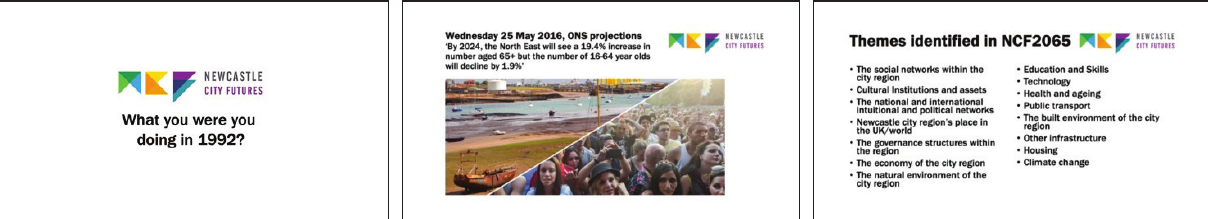
Figure 1. Examples of prompt slides used during LEGO® mash‐up, from an icebreaker question to introducing place issues. Urban Planning, 2022, Volume 7, Issue 2, Pages